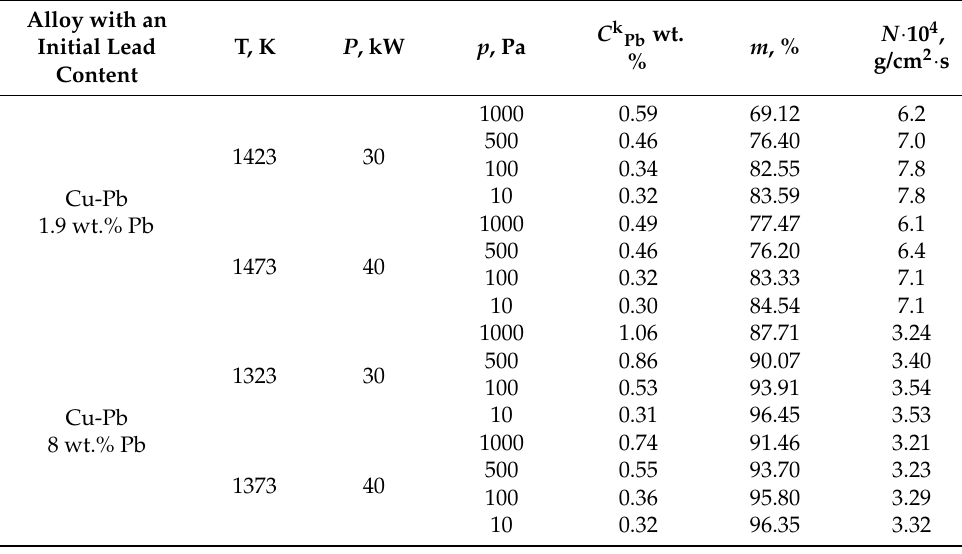
Table 4. Results of experiments carried out in an induction vacuum furnace.